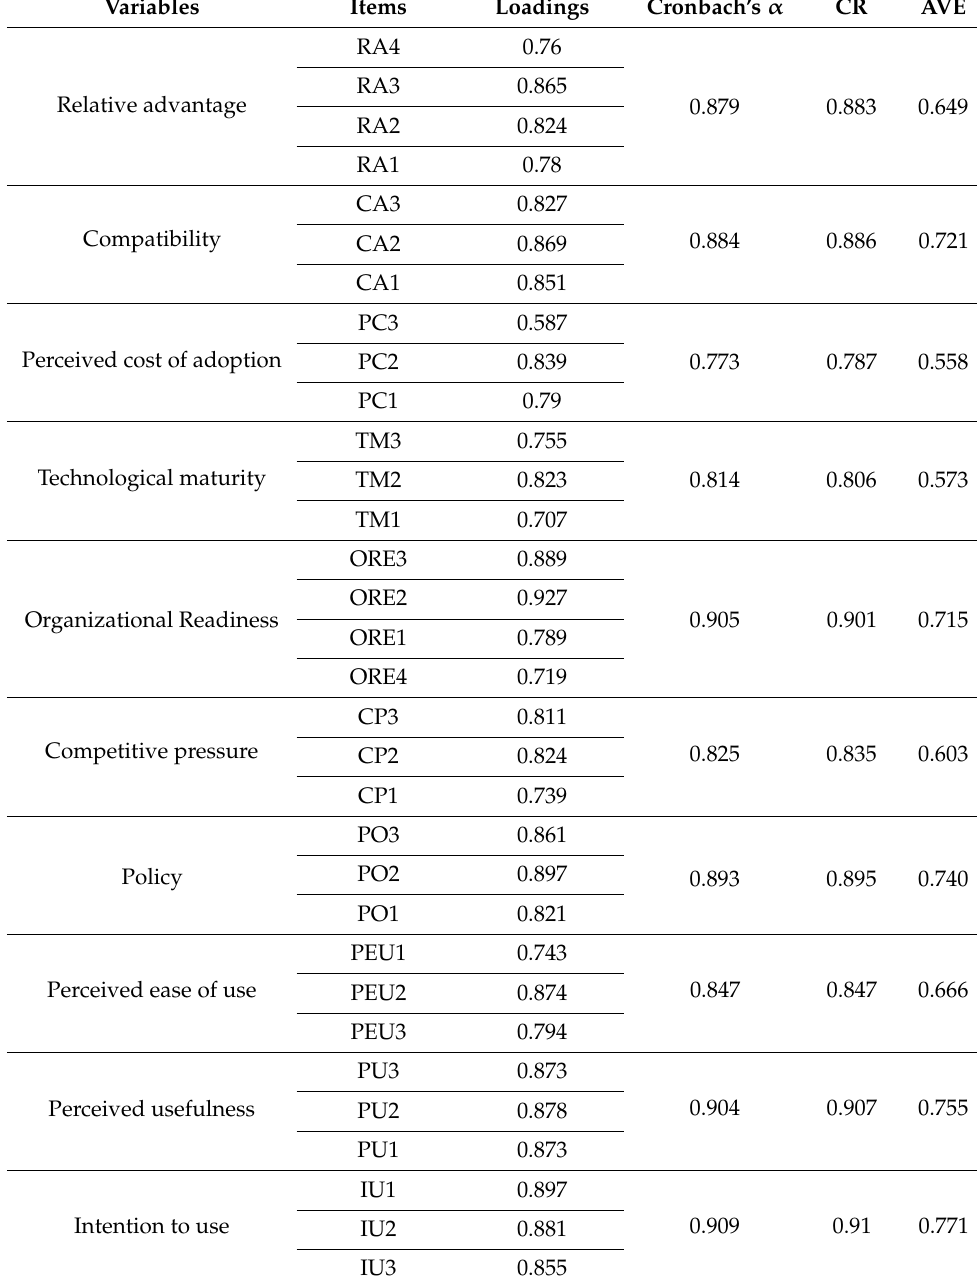
Table 3. Reliability and convergence validity